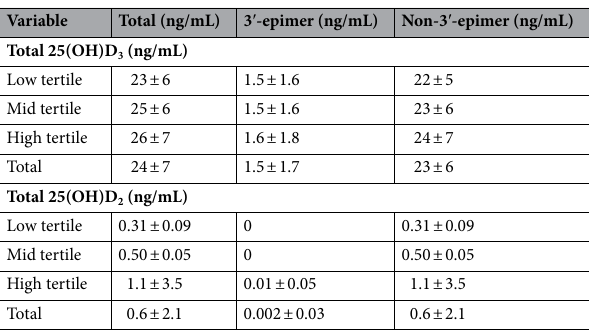
Table 2. Composition of 25(OH)D according to its epimeric and nonepimeric forms according to 25(OH)D